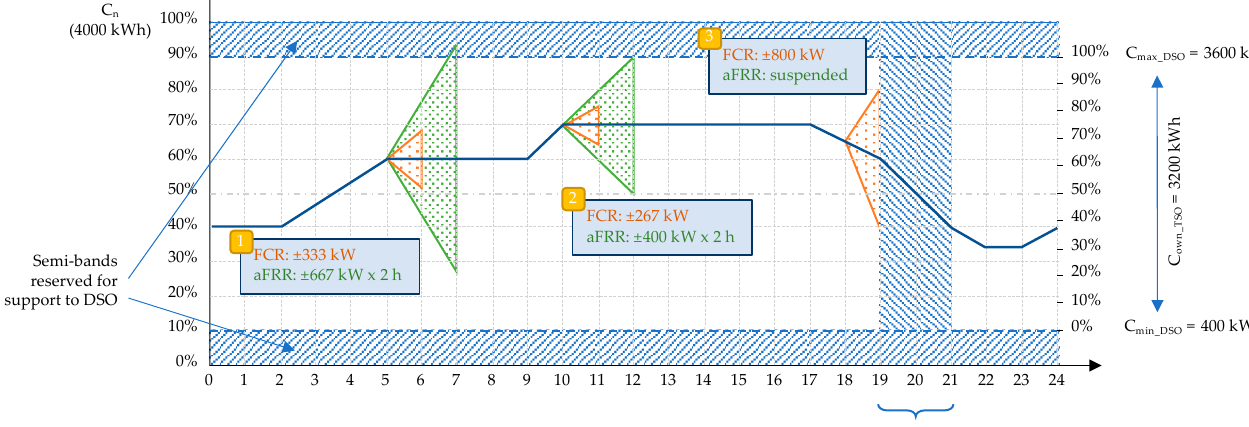
Figure 5. Examples of available flexibility for TSO services ( r FCR = 1/3 and Δ t aFRR = 2 h).